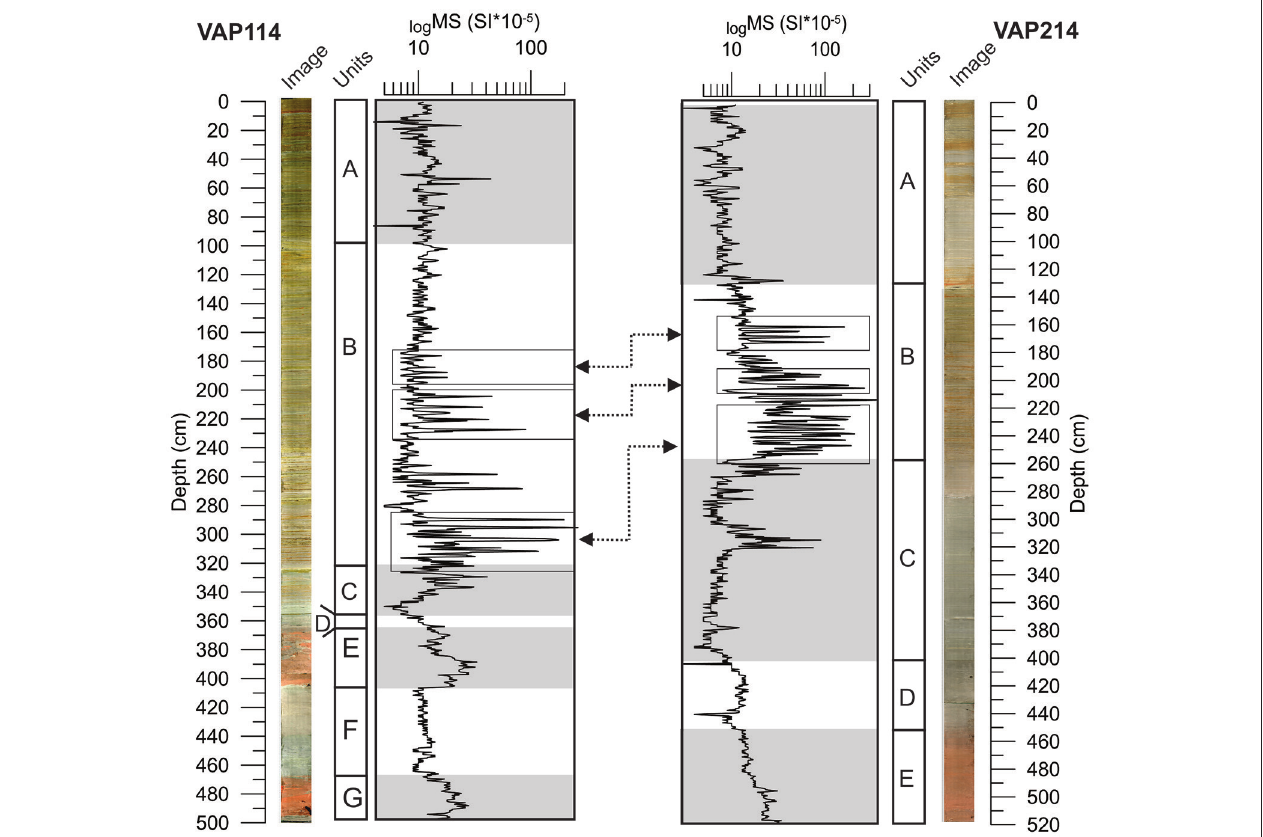
FIGURE 6 | Magnetic susceptibility of VAP114 and VAP214 on a log scale. The two sediment cores from Vårfluesjøen are divided into units based on lithostratigraphy. The small squares suggest common features in the MS results.